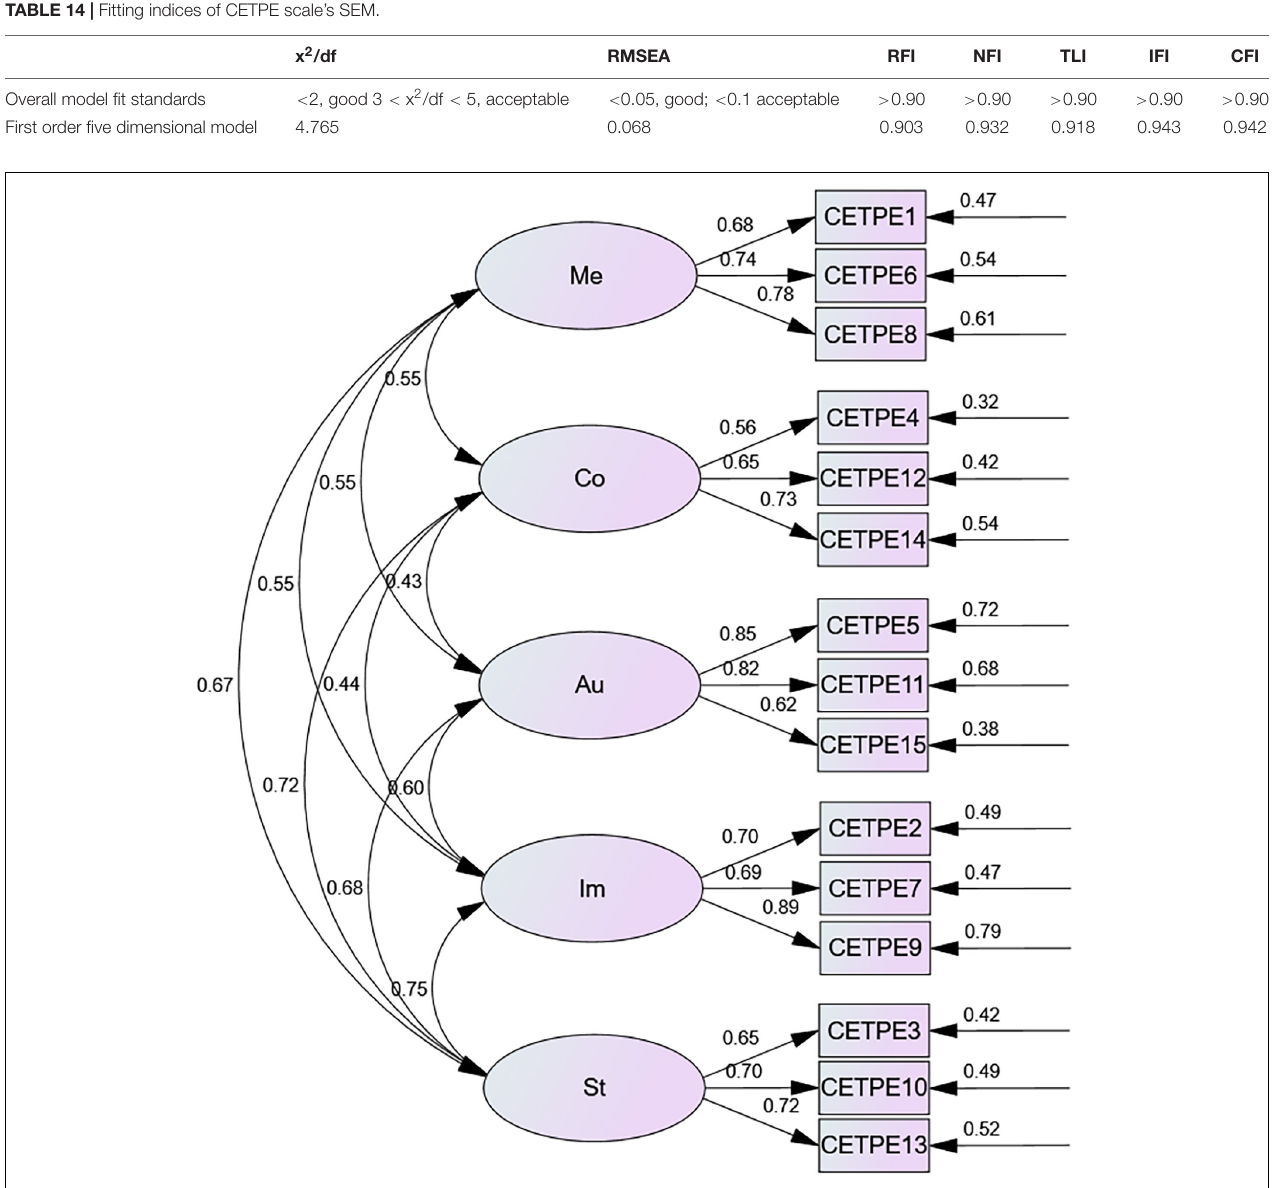
FIGURE 2 | CETPE’s five dimensional model. Among the variables of the model, Me, Meaningfulness; Co, Competence; Au, Autonomy; Im, Impact; St, Status; CETPE, college English teachers’ psychological